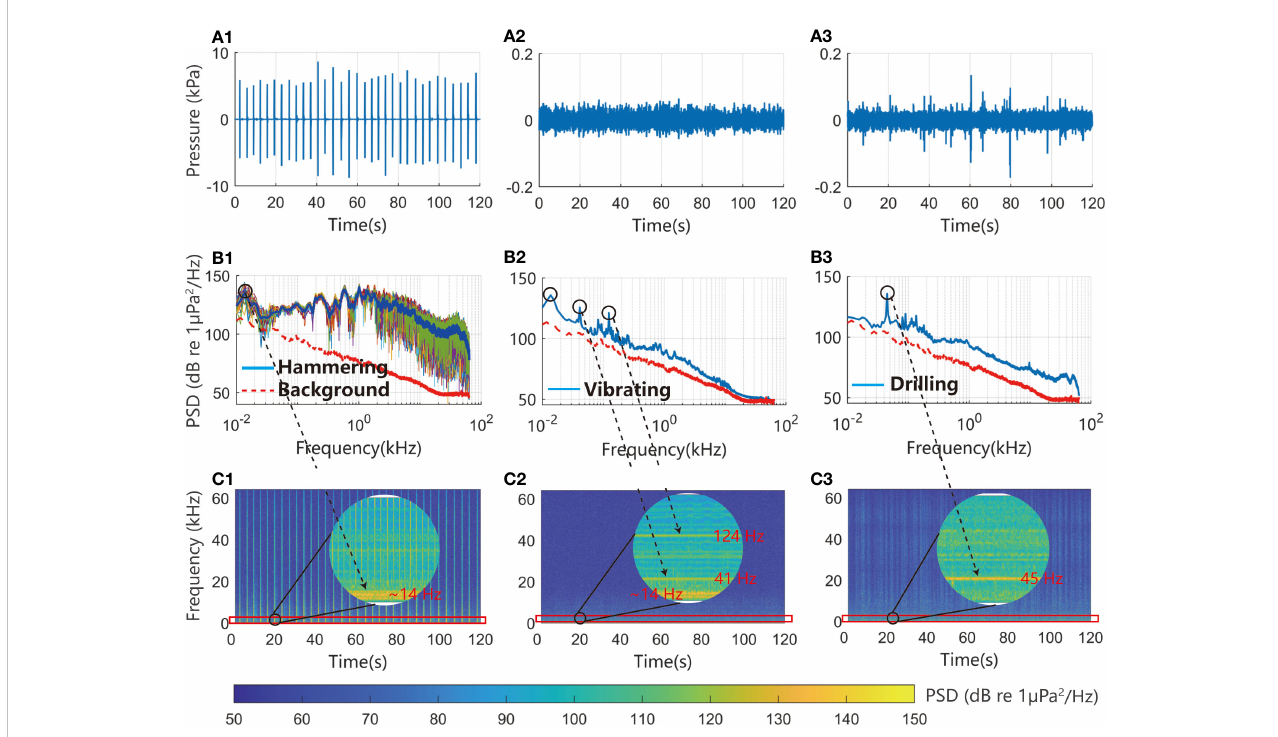
FIGURE 3 The time waveforms (A1-A3) , spectrum diagrams (B1-B3) , and spectrograms (C1-C3) of hammering noise, vibrating noise and drilling noise measured at the station 1 during OED. The spectrum diagrams in sound pressure power spectral density (PSD) level were generated with Welch ’ s method (Welch, 1967), using 65,536 sample hamming windows with 80% overlap. The spectrograms in PSD level were generated using short-time Fourier transform (hamming window, window size: 65,536, overlap: 80%). The colored, thin lines in (B1) are single strikes of hammering noise, and the blue, thick line is the average. The circles in (C1-C3) are the local enlargements of